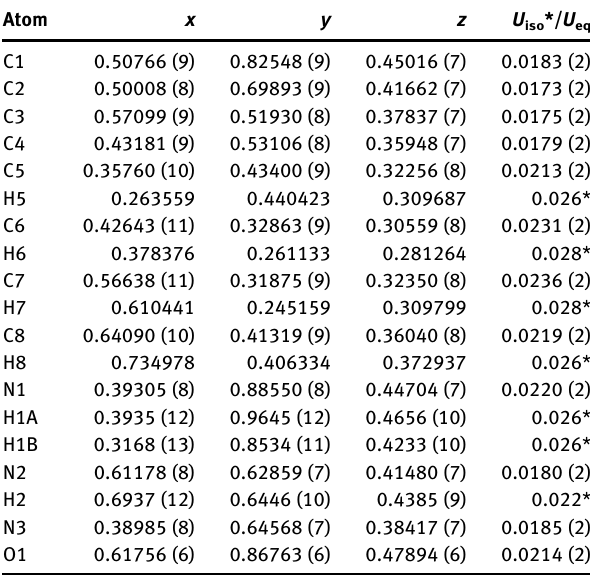
Table  : Fractional atomic coordinates and isotropic or equivalent isotropic displacement parameters (Å  ).